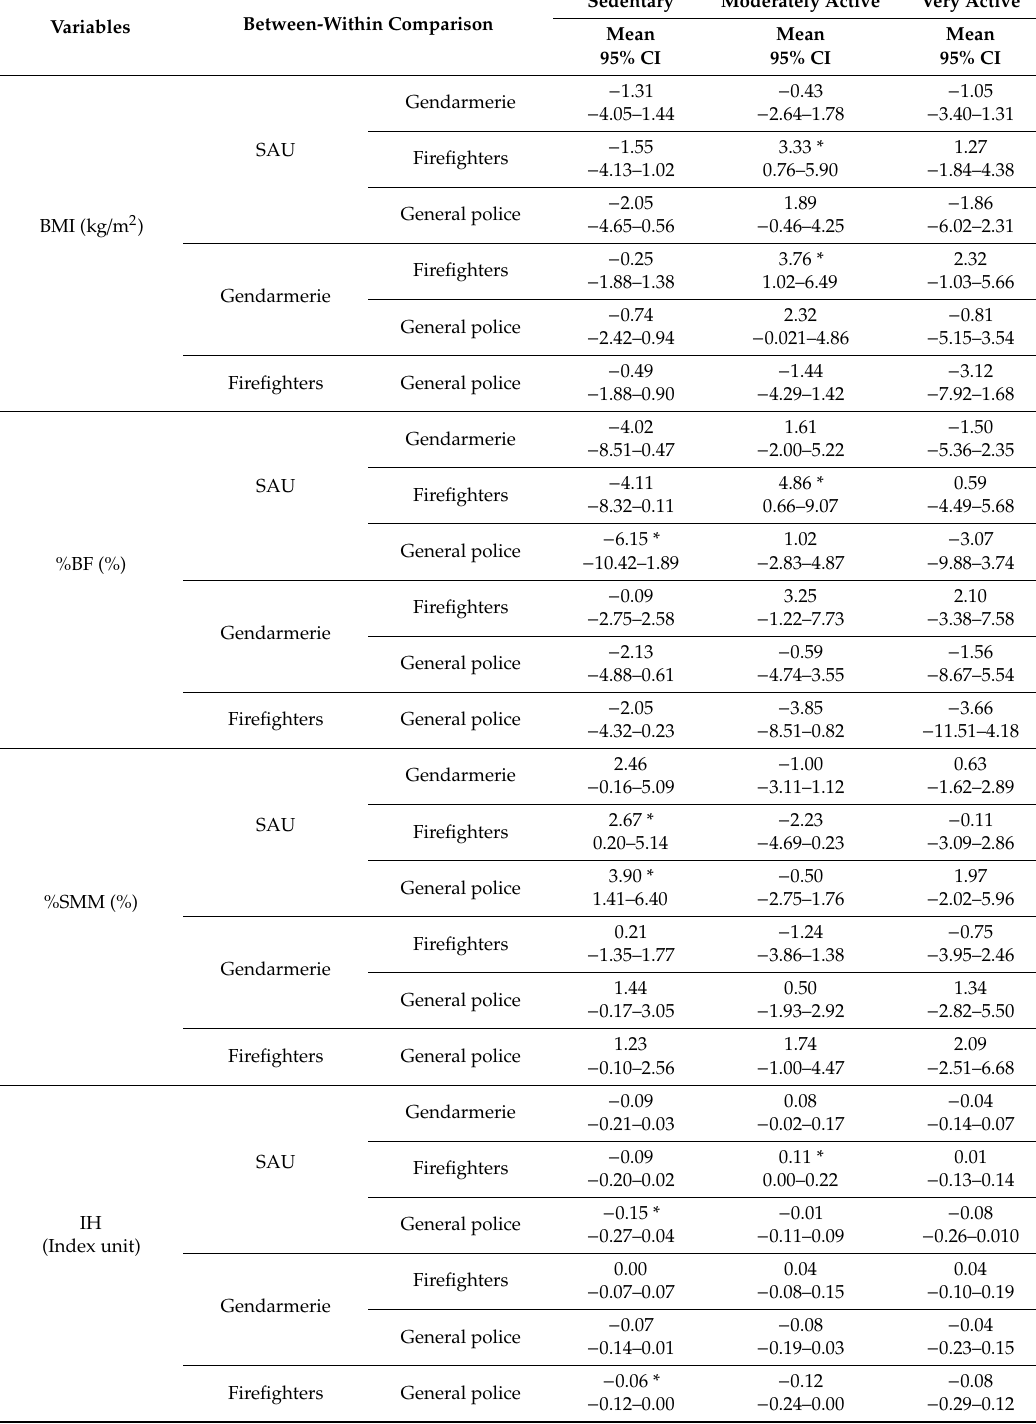
Table 5. Between-occupation di ff erences in body composition relative to leisure-time physical activity obtained by Bonferroni post hoc